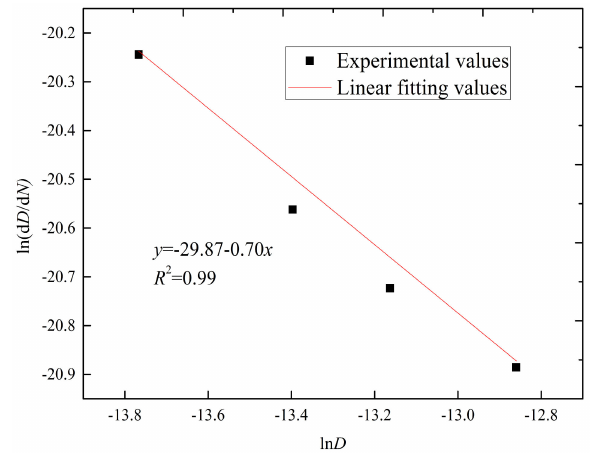
Figure 9. ln-ln plot of d D /d N versus D